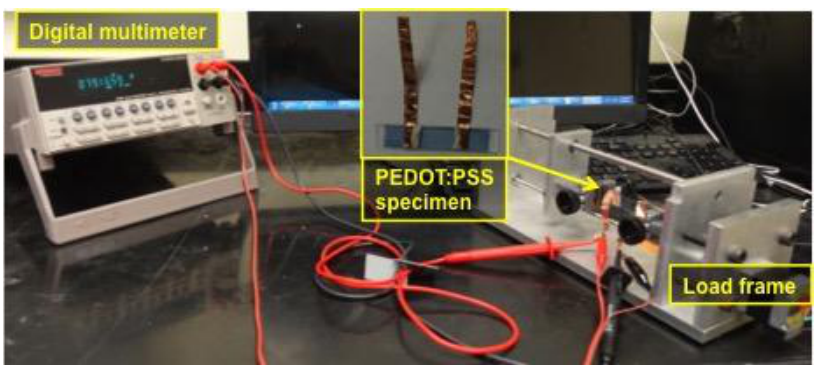
Figure 3. Electrical connections were established on the corrugated PEDOT:PSS thin film specimen to measure four-point probed resistance using a digital multimeter. The specimen is strained using the custom-built load frame to measure the resistance at various tensile strains.